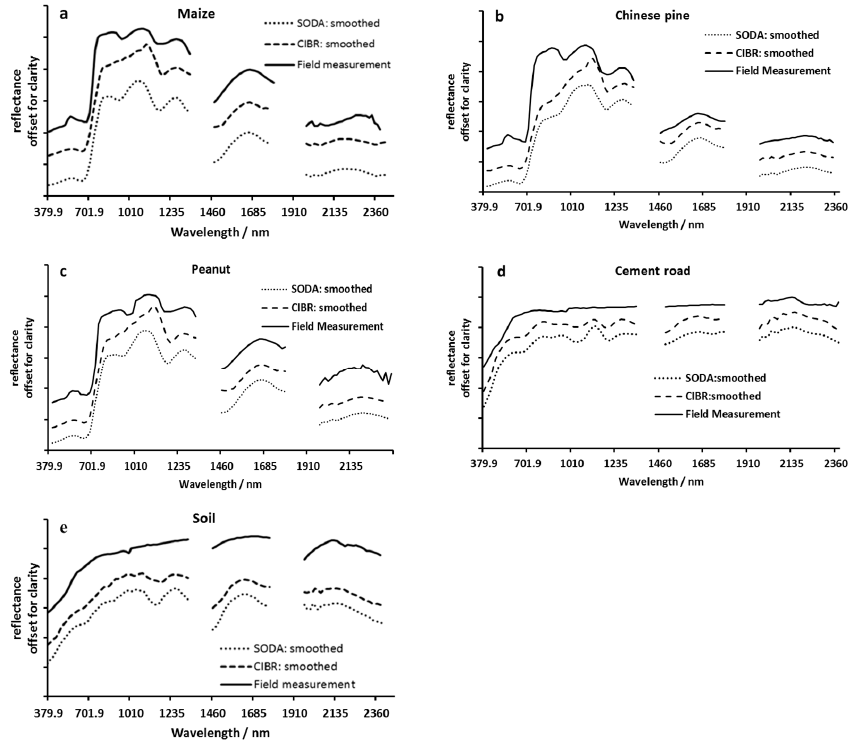
Figure 10. Spectra from Figure 9a,b smoothed with a moving average and offset. ( a ) Maize, ( b ) Chinese pine, ( c ) Peanut, ( d ) Cement road, and ( e ) Soil. Symbol SODA is the second-order difference algorithm to retrieve columnar water vapor and CIBR is Continuum Interpolated Band Ratio algorithm to retrieve columnar water vapor. Symbol “smoothed” is that the surface reflectance spectra are calculated using smoothing techniques.